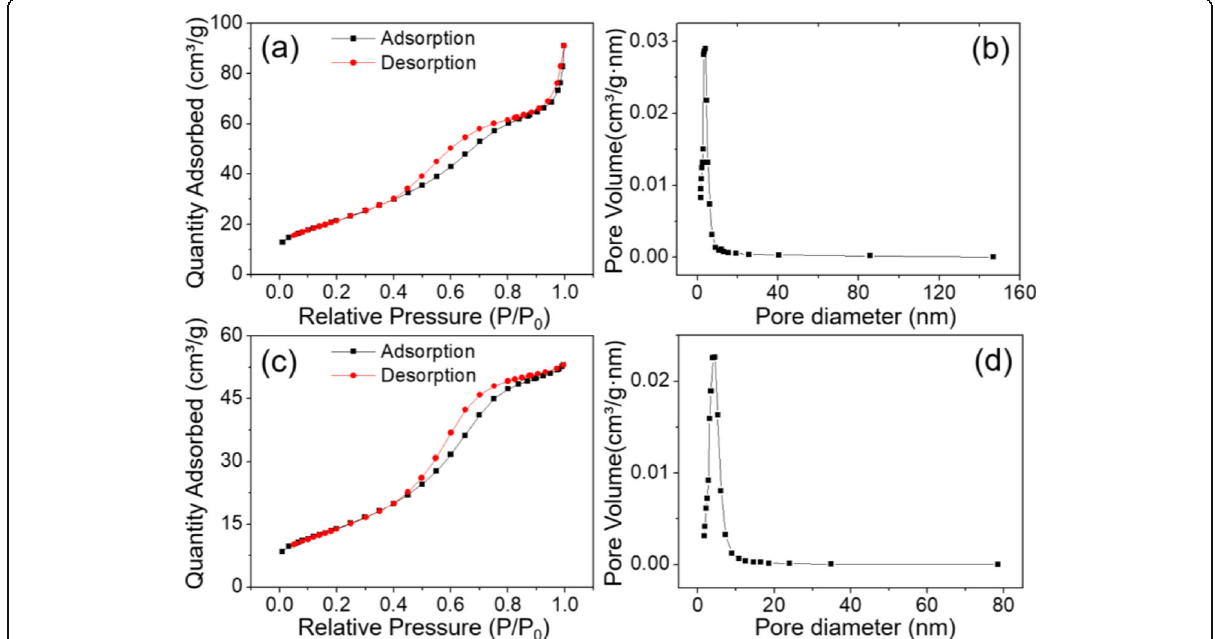
Fig. 5 N 2 adsorption-desorption isotherms and the corresponding BJH pore size distributions for a , b porous Co 3 O 4 cubes and c , d porous Co 3 O 4 nanosheets,